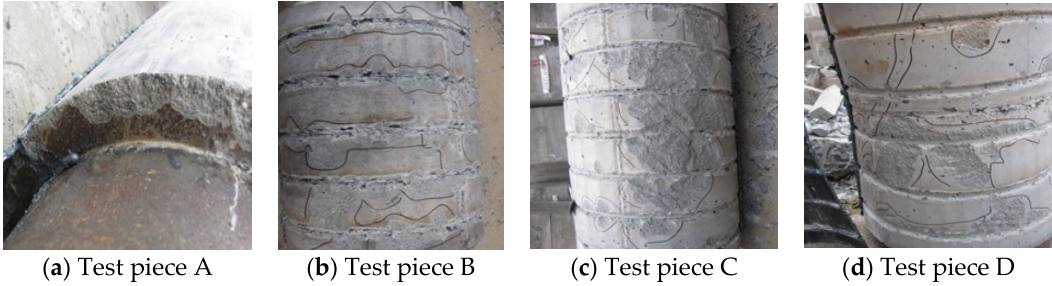
Figure 7. Cleavage of the specimens.